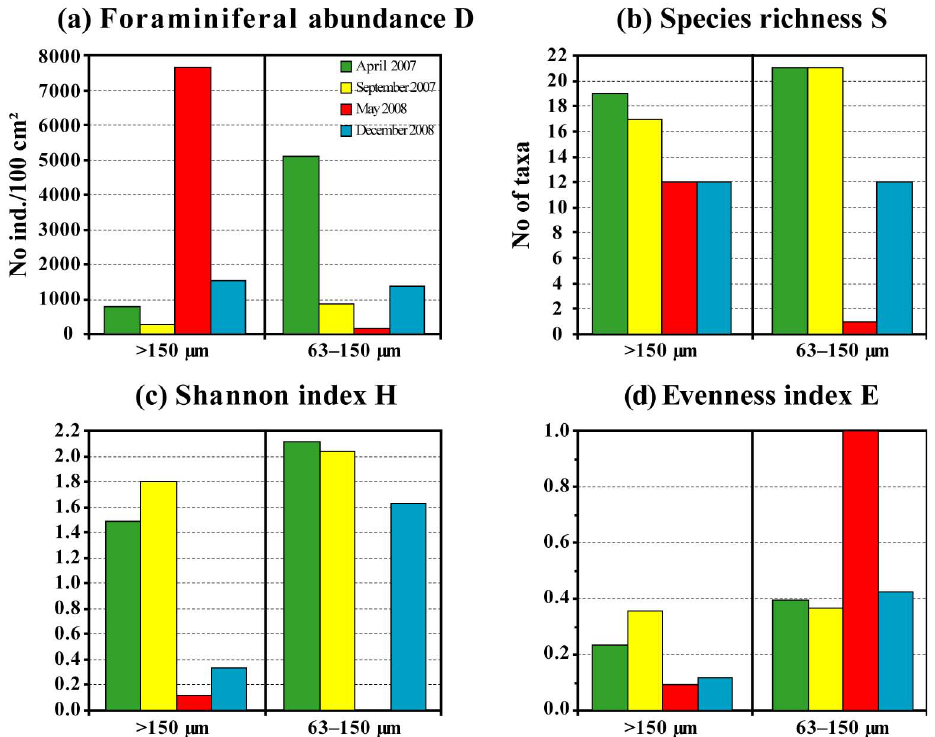
Fig. 5. Foraminiferal abundance D standardised for a surface area of 100cm 2 (core surface: 72cm 2 ; sediment depth: 0.5cm for the 63– 150µm size fraction and 5cm for the > 150µm size fraction) (a) , species richness S (b) , Shannon index H (c) and Evenness index E (d) of the total living foraminiferal faunas in the > 150µm and 63–150µm size fractions at Station A for the four sampling